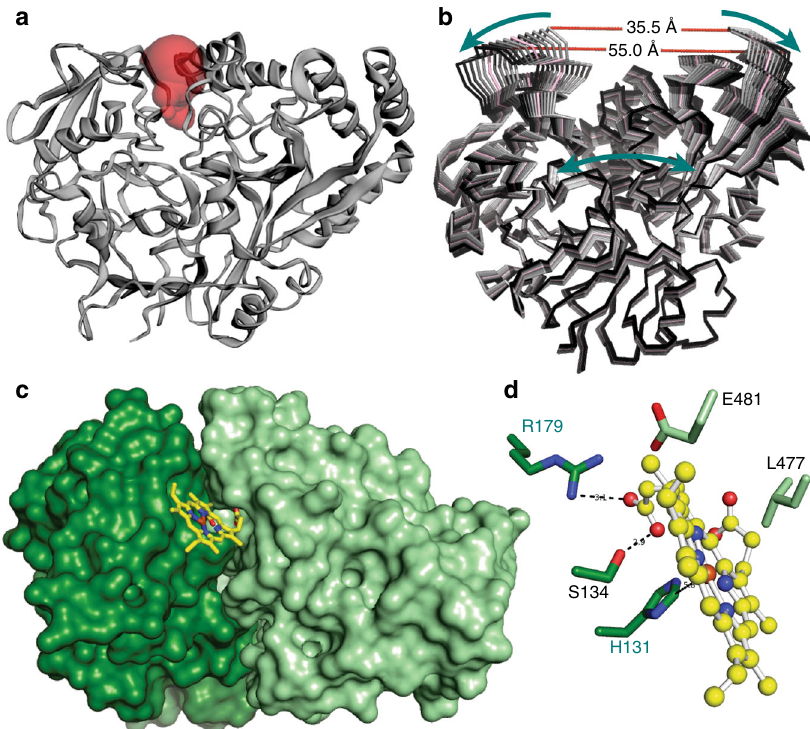
Fig. 5 Structure-based identi fi cation of a heme-binding pocket in M. tuberculosis DppA. a Ribbon diagram of DppA overlaid with the volume of the solvent- accessible pocket identi fi ed by CASTp. The pocket has a Richards ’ solvent-accessible surface area of 333.4 Å 2 and solvent-accessible volume ~268.4 Å 3 . b Superimposition of the 10 perturbed conformations of DppA obtained by applying normal mode analysis using three lowest frequency normal modes. The arrows show the direction of opening of the two N- and C-terminal halves. The crystallographic model of DppA wt is colored in red, while all other states are ramped from light gray (most closed) to black (most open). c Docking model of heme (in yellow sticks) bound to the open conformation of DppA (shown as solvent surface with N- and C-terminal halves color-coded as in a ). d Zoom-view of DppA residues making contact with